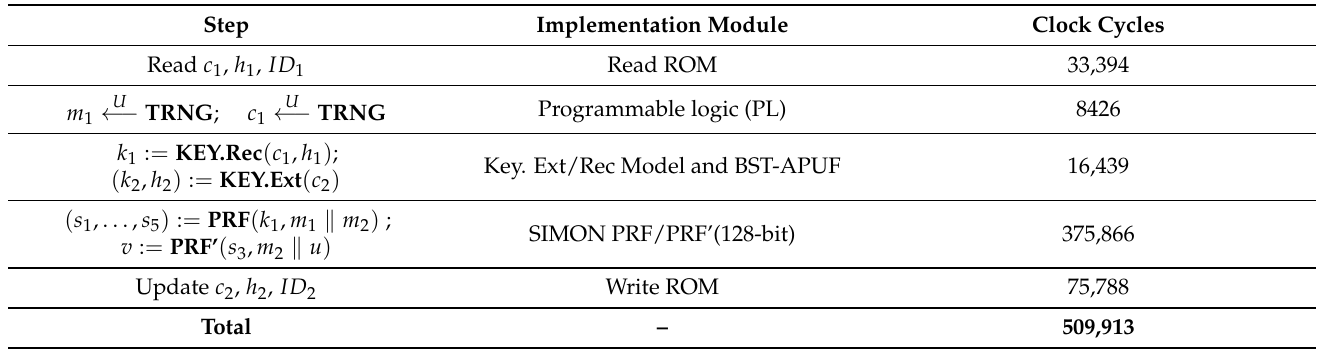
Table 4. The execution time of the proposed